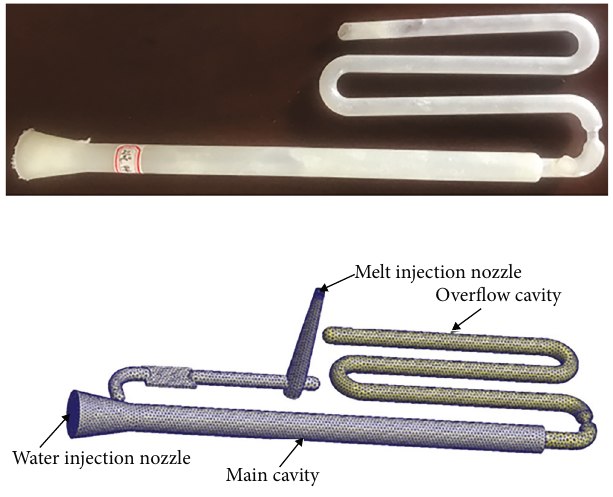
Figure 1: over fl ow water-assisted injection model. Table 2: The process